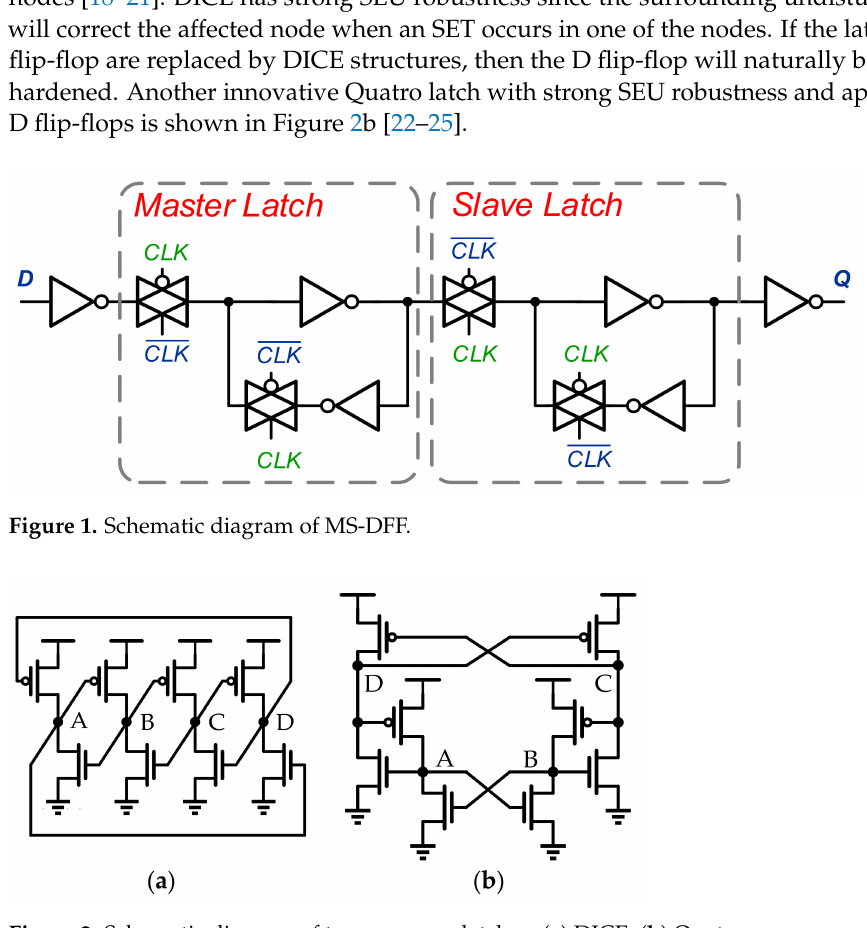
Figure 2. Schematic diagram of two common latches: ( a ) DICE; ( b )